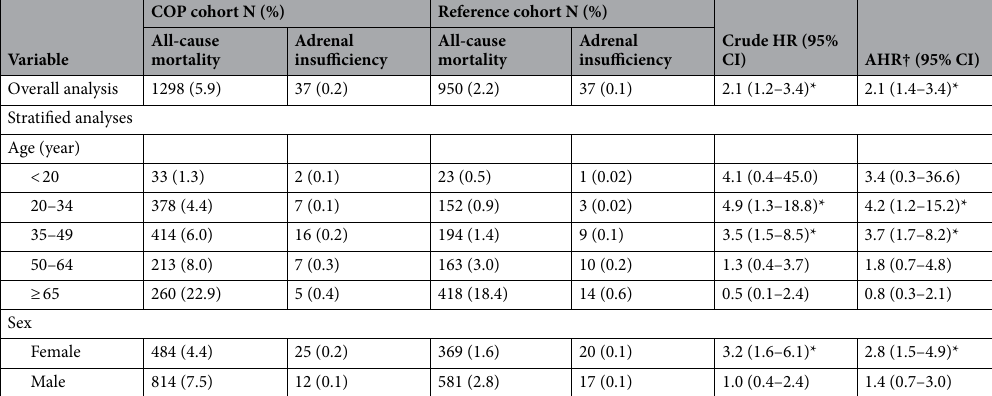
Table 4. Comparison of the risk for adrenal insufficiency after more than 1 year of follow-up between the COP and reference cohorts using competing risk survival analyses. COP carbon monoxide poisoning; HR hazard ratio; AHR adjusted hazard ratio; CI confidence interval. * p < 0.05. †Adjusted for sex, underlying comorbidities including liver disease, thyroid disease, and mental